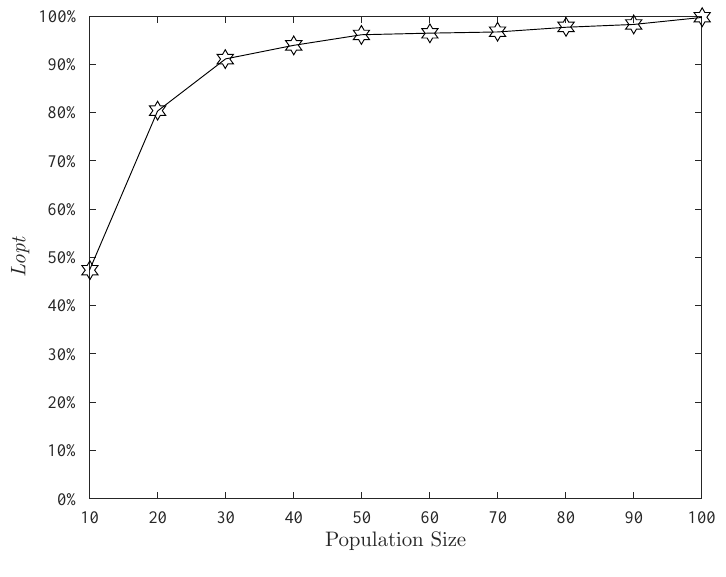
Figure 12. Effect of the population size.